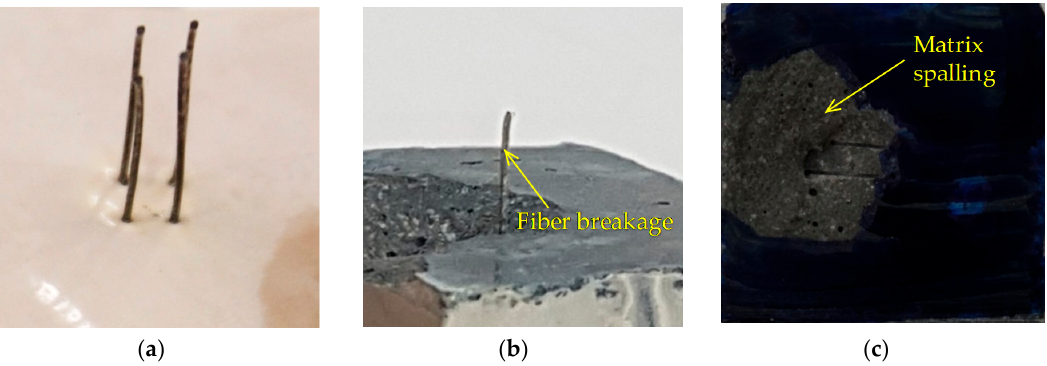
Figure 11. Failure modes of H-fibers according to inclination angle at impact loads: ( a ) aligned H-fiber, ( b ) inclined H-fiber, and ( c ) matrix spalling.